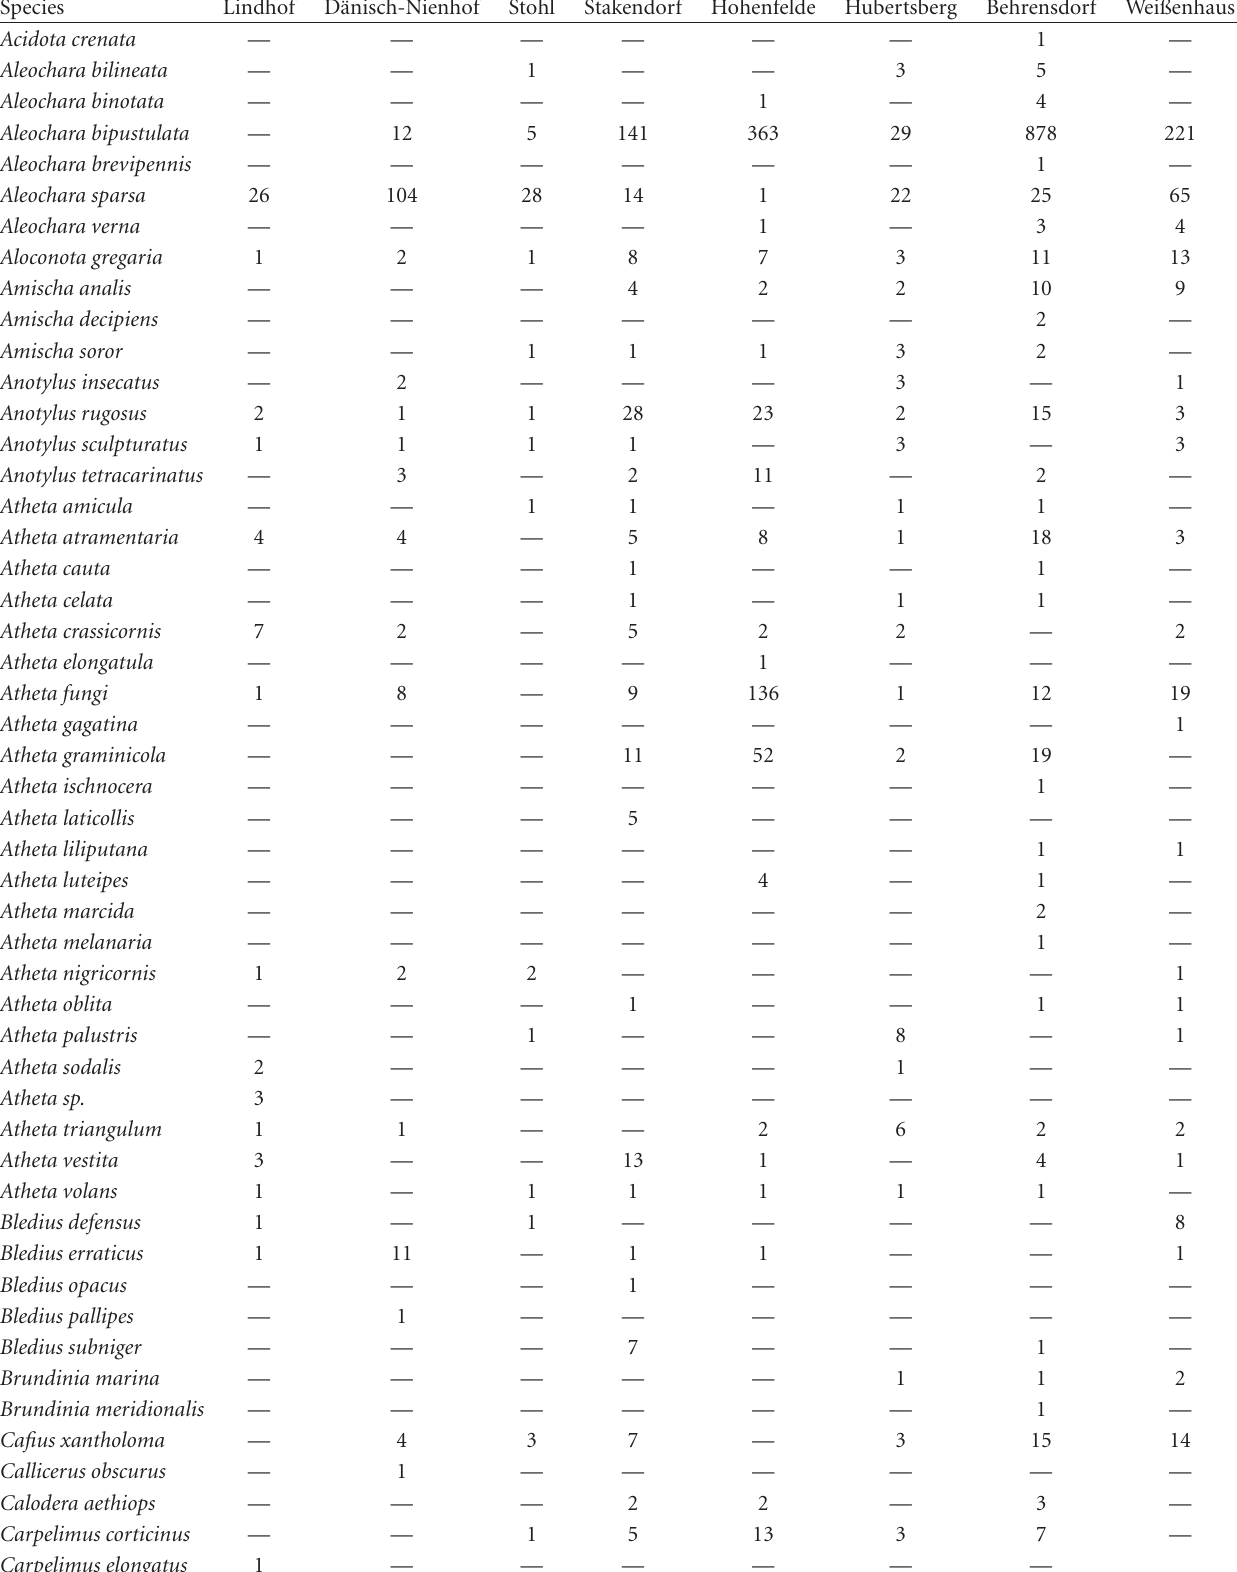
Table 6: List of staphylinid species (total number of individuals) at the investigated